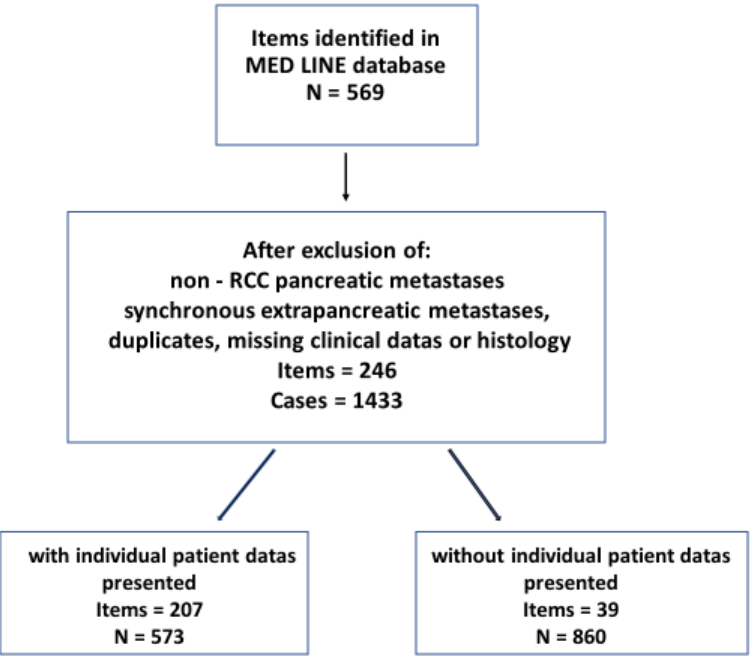
Figure 1. Search and selection strategy.